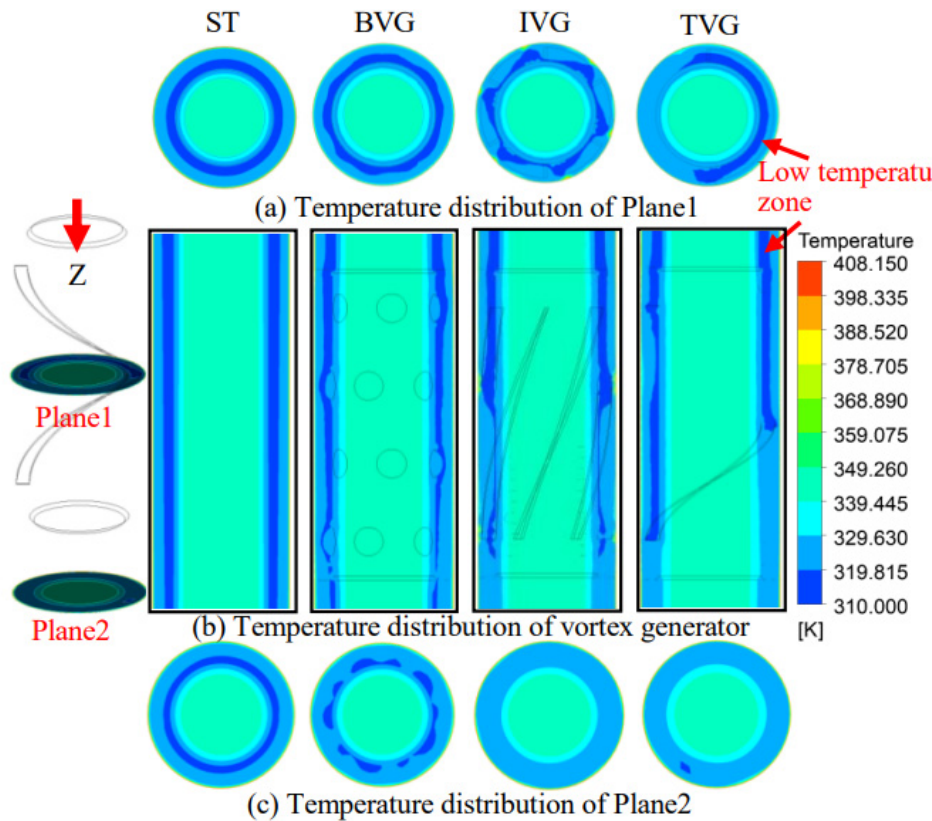
Figure 12. Temperature distributions in the vortex generator area of the four heat exchangers.